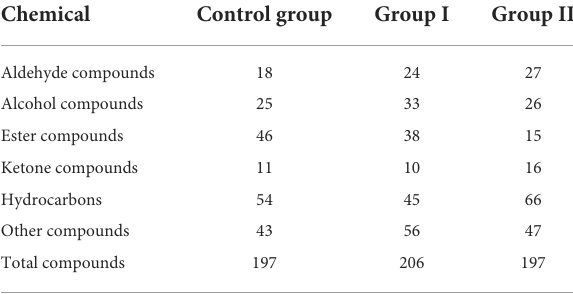
TABLE 10 Effects of dietary protein level on volatile compounds in the muscle of finishing pigs.